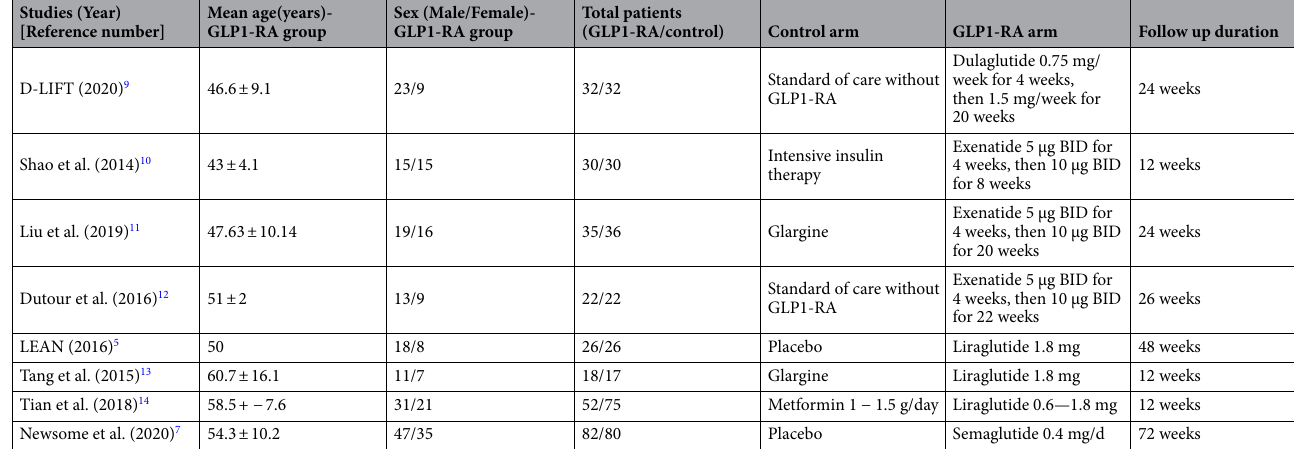
Table 1. Baseline characteristics of the citations included for